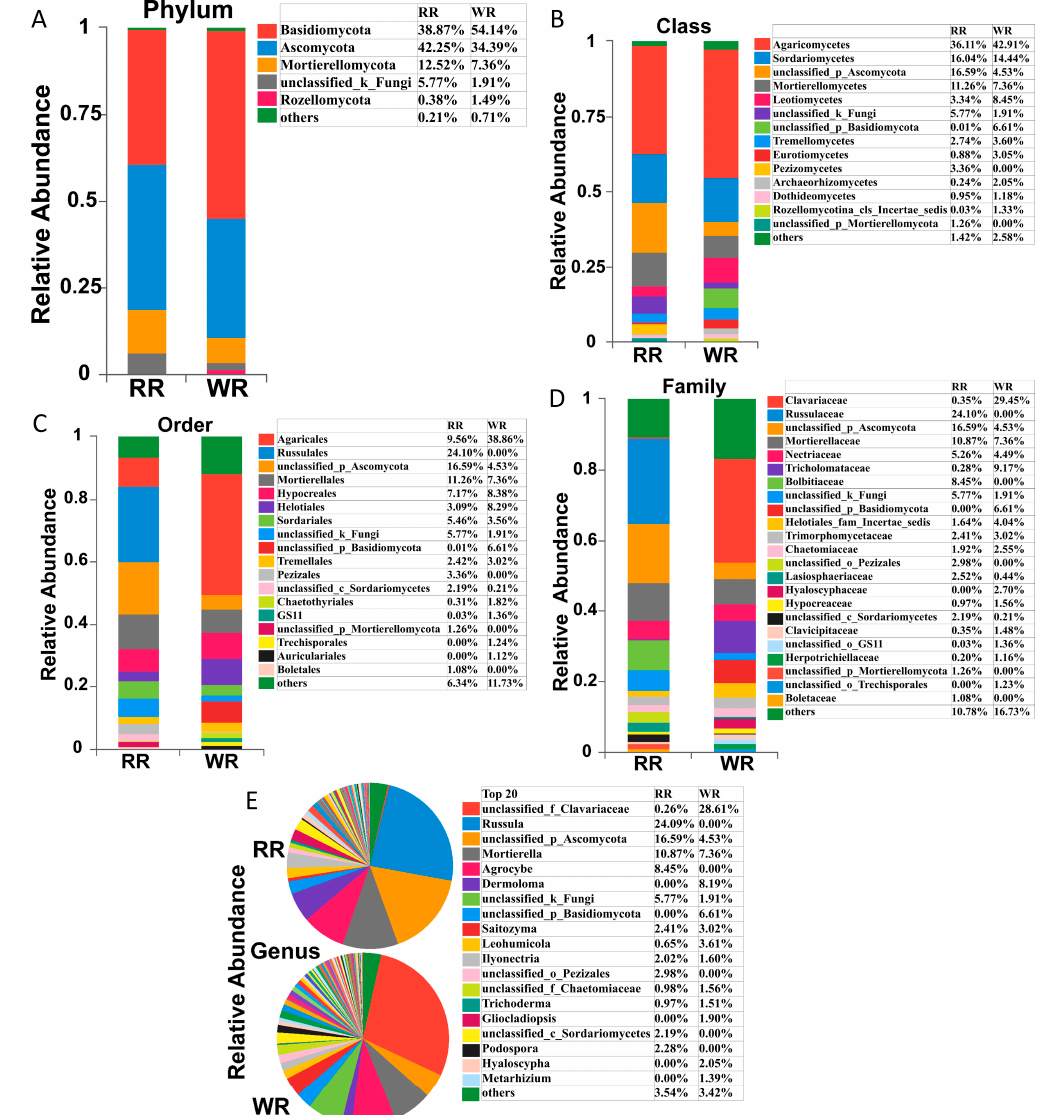
Figure 2. Relative abundances of fungal taxa in rhizospheric soil samples from wild and reintroduced M. sinica at the phylum ( A , all phyla with relative abundance greater than 1%), class ( B , all classes with relative abundance greater than 1%), order ( C , all orders with relative abundance greater than 1%), family ( D , all families with relative abundance greater than 1%), and genus ( E , the top 20 most abundant genera) levels. The remaining members with a relative abundance of < 1% are denoted as “others” (rhizospheric soil samples from wild plants (WR, n = 3); rhizospheric soil samples from reintroduced plants (RR, n =